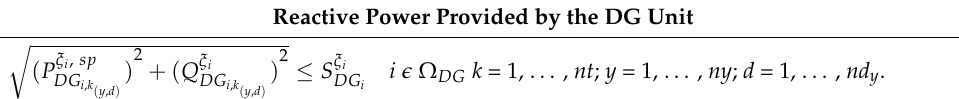
Table 3. Constraints on distributed generation (DG)